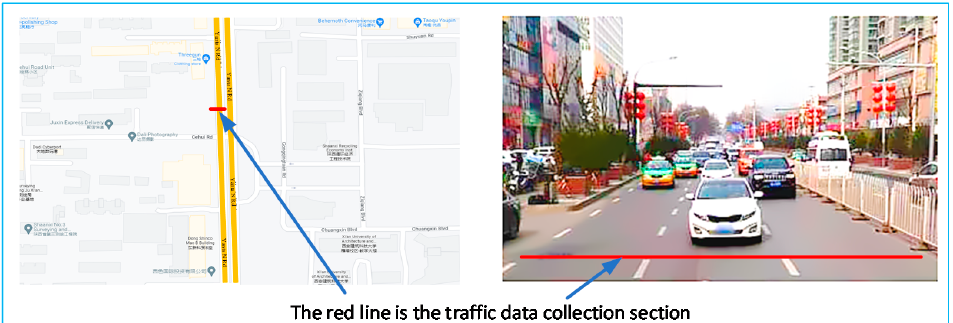
Figure 9. Scope of traffic flow data collection.